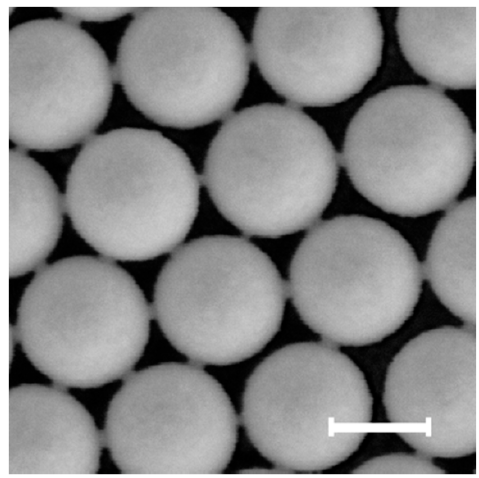
Figure 5. SEM micrograph showing polystyrene particle necking induced by reactive ion etching (scale bar = 200 nm ).